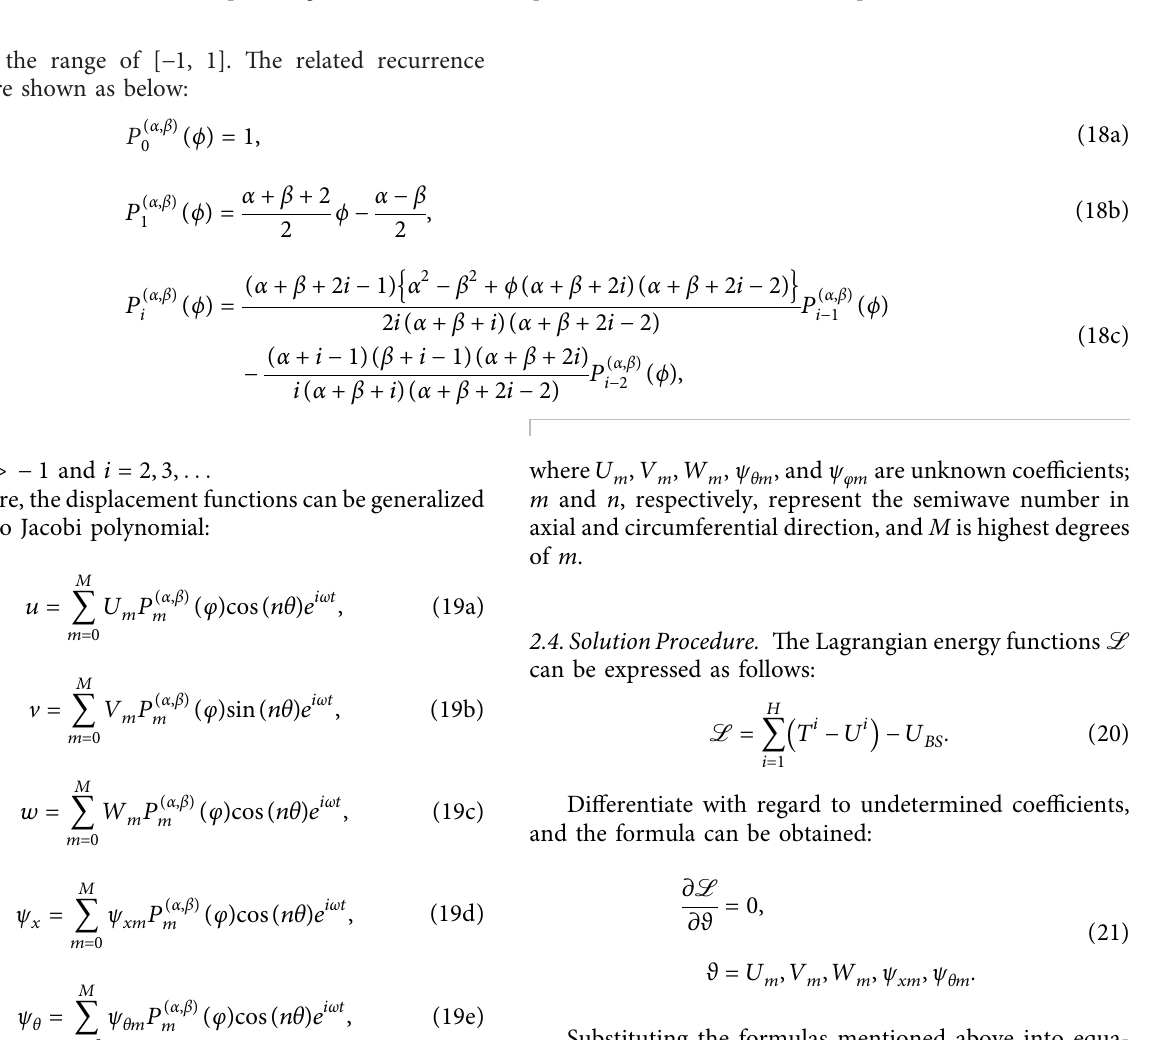
Figure 5: Relative percentage error of the annular spherical shell with different Jacobi